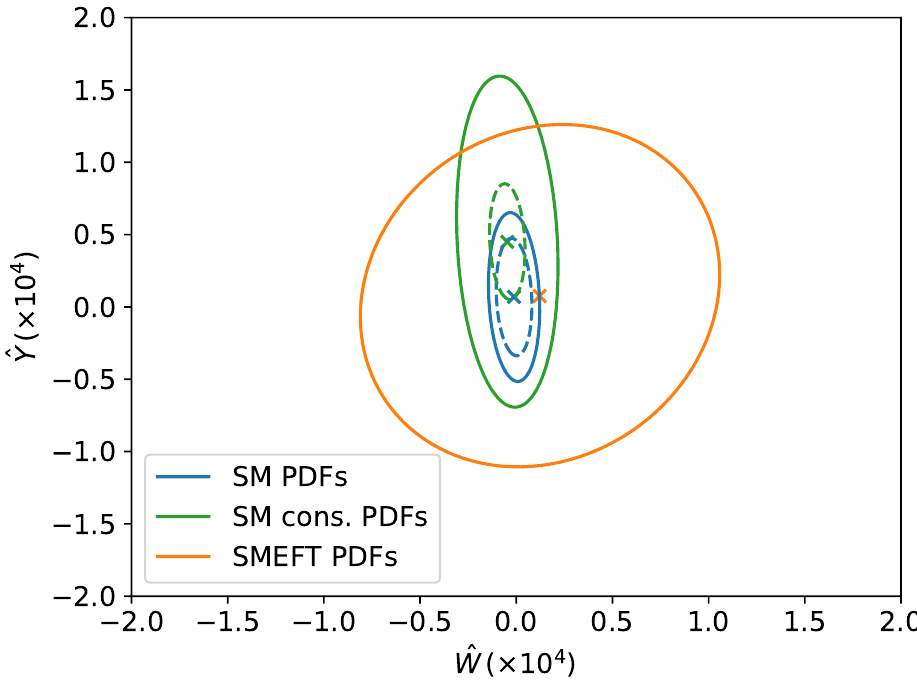
Figure 15 . The 95% confidence level contours in the ( ˆ W , ˆ Y ) plane obtained from the DIS+DY fits that include the high-mass Drell-Yan HL-LHC pseudo-data (both in the NC and CC channels) when using either SM PDFs (blue) or conservative SM PDFs (green). In both cases the ellipses are obtained by performing a parabolic fit to χ 2 with fixed PDFs. PDF uncertainties are included in smp the solid lines and not included in the dashed lines. The results are compared to those obtained in a simultaneous fit, namely with SMEFT PDFs (orange). In this case, the parabolic fit is performed to χ 2 by varying simultaneously the Wilson Coefficients and the PDFs. The crosses indicate the eftp best fits in the three cases discussed in the